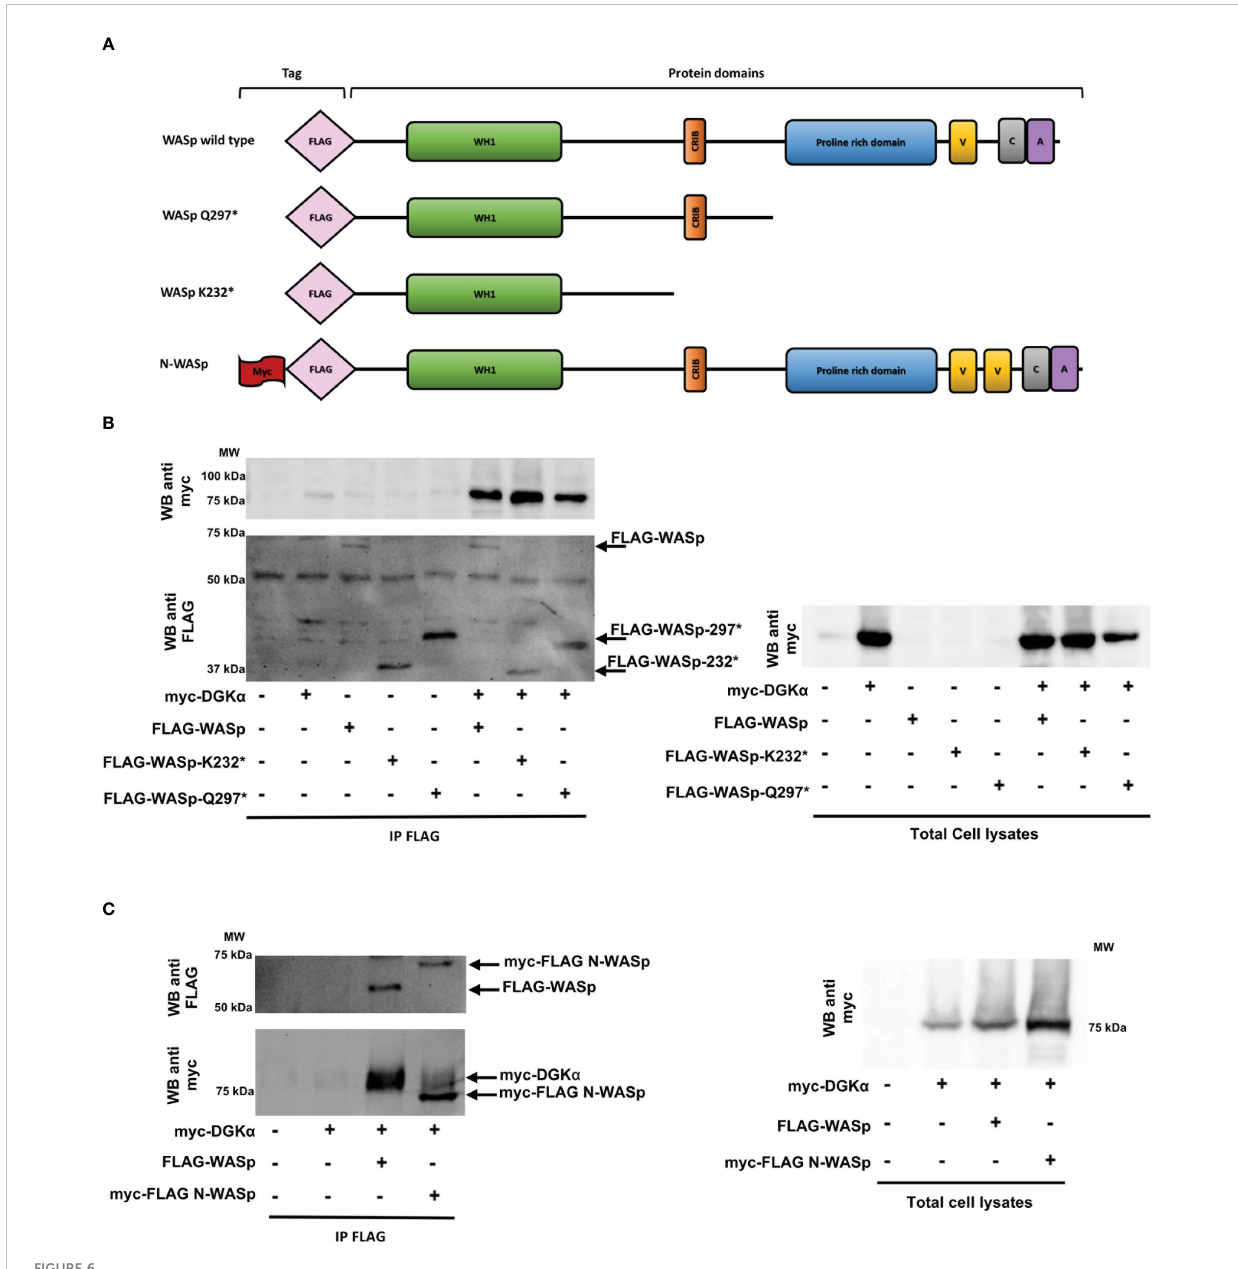
FIGURE 6 WASp interacts with DGK a through the WH1 domain while N-WASp does not bind HEK 293-T cells were co-transfected with the indicated plasmids. 48 hours later, proteins were immunoprecipitated with anti-FLAG antibody and subsequently analysed by western blotting. (A) WASP constructs used with domains and tags evidenced. (B) Interaction between myc-DGK a and FLAG-WASp or FLAG-WASp deletion mutants (FLAG-WASp K232* and FLAG-WASp Q297*) and the corresponding total cell lysates. (C) Interaction between FLAG-WASp or myc-FLAG N-WASp with myc-DGK a WT and the corresponding total cell